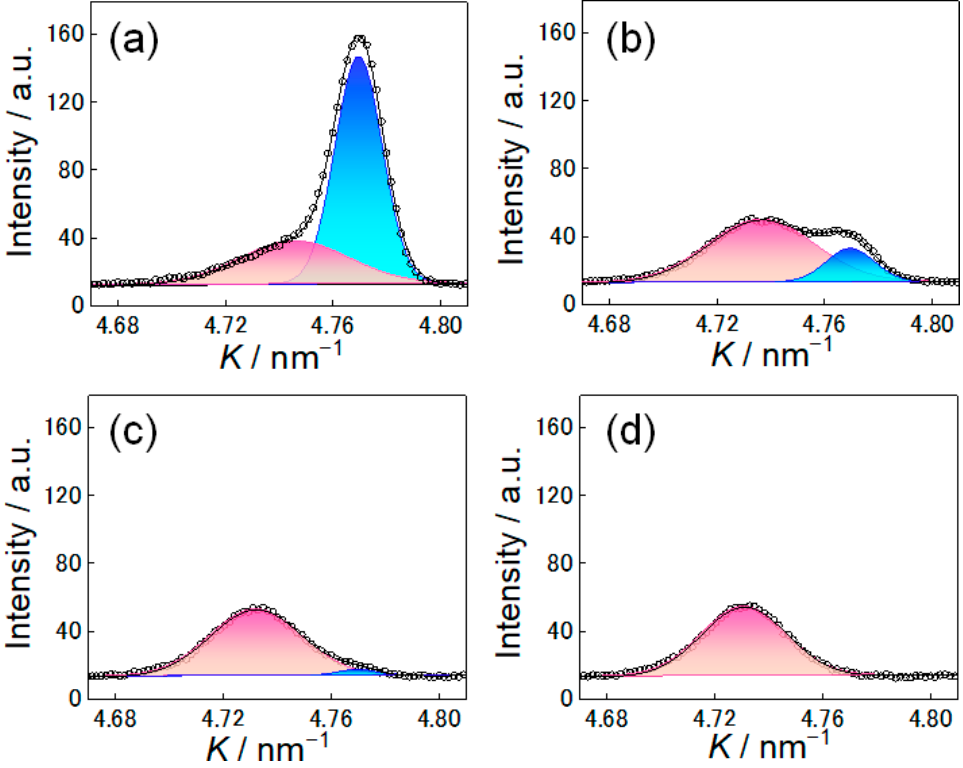
Figure 4. The splitting of the 111 γ diffraction peak observed during the isothermal heating at 673 K. The images correspond to different time spans, ( a ) 0 − 200 s, ( b ) 200 − 400 s, ( c ) 400 − 600 s, and ( d ) 600 − 800 s. The origin of the time is the beginning of isothermal heating. The observed intensities are shown as open circles tied with black lines. The split peak observed at each time span was fitted by pink and blue Gaussian peaks representing the high and low carbon austenite, respectively. The magnitude of the scattering vector, K , is defined as K = 1/ d = 2sin θ / λ .